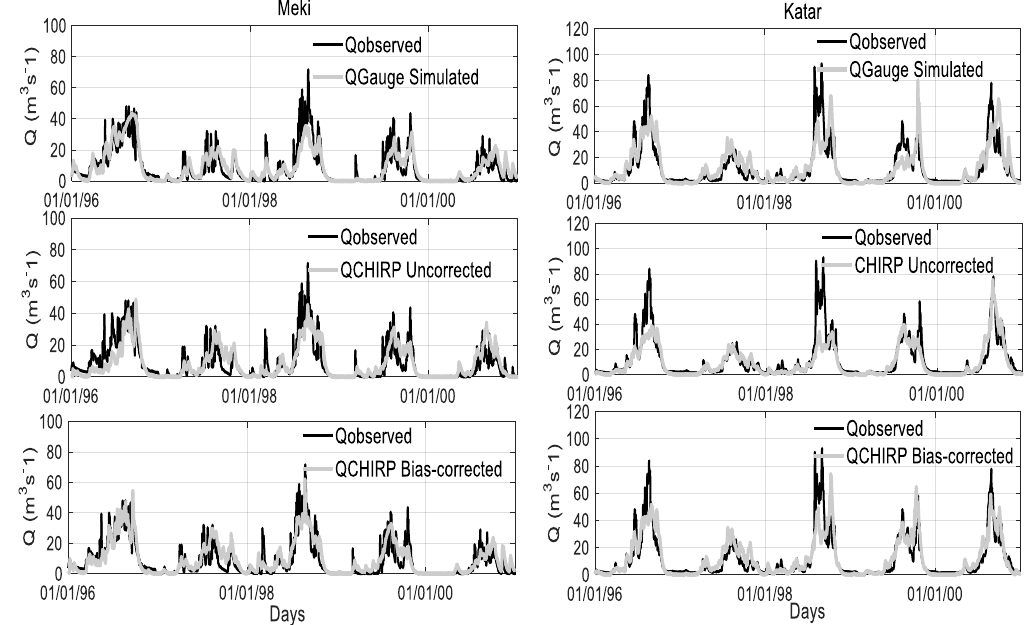
Figure 11. Model validation result (1996–2000) between daily observed and simulated flow of Meki and Katar catchments using gauge, uncorrected, and bias-corrected CHIRP rainfall inputs.